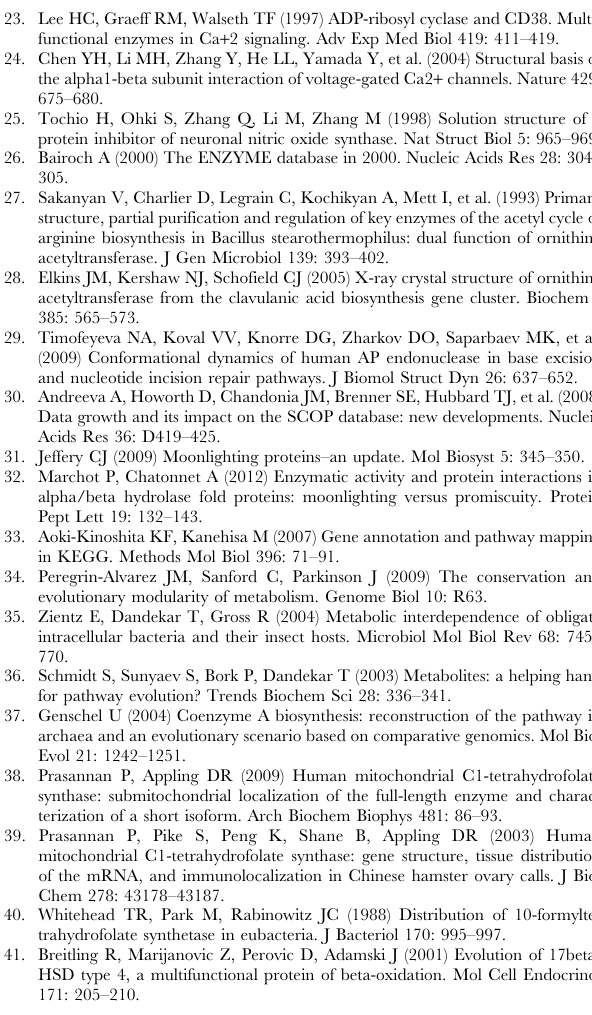
Figure S1 The KEGG ontology analysis of known MCD- MFEs. Total 4,123 known multifunctional enzymes of multiple catalytic/functional domains (MCD-MFEs) were included in the analysis. Figure S2 The KEGG ontology analysis of known SMAD- MFEs. Total 812 known multifunctional enzymes of single multi- activity domain (SMAD-MFEs) were included in the